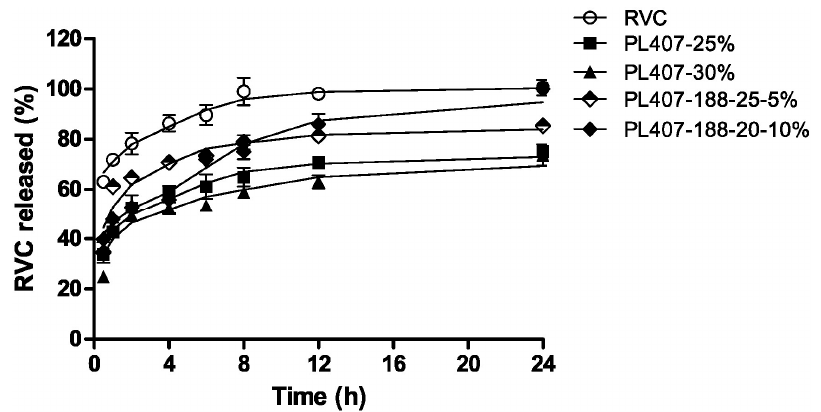
Figure 2. Release profiles of ropivacaine from poloxamer 407 (P407) and P407/poloxamer 188 (P188) hydrogels [42].